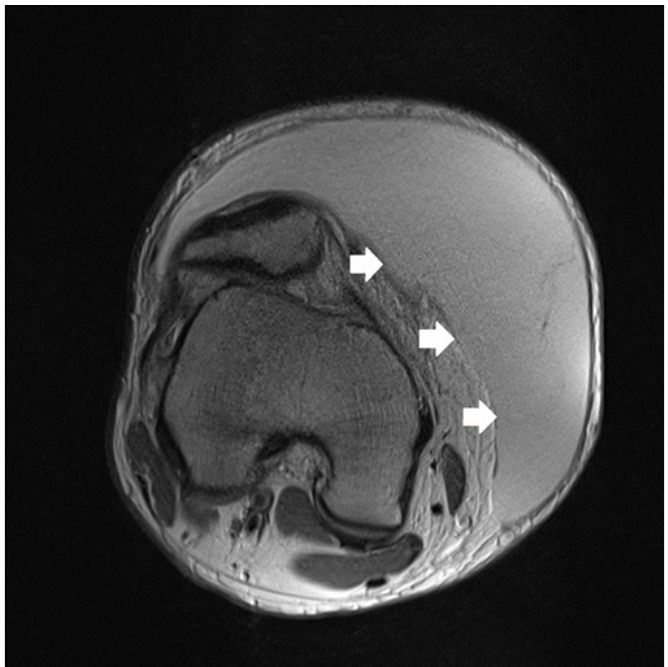
Figure 2a. Axial proton density high resolution magnetic resonance imaging shows T2 prolongation in the Morel-Lavallee lesion of the anteromedial right thigh soft tissues.